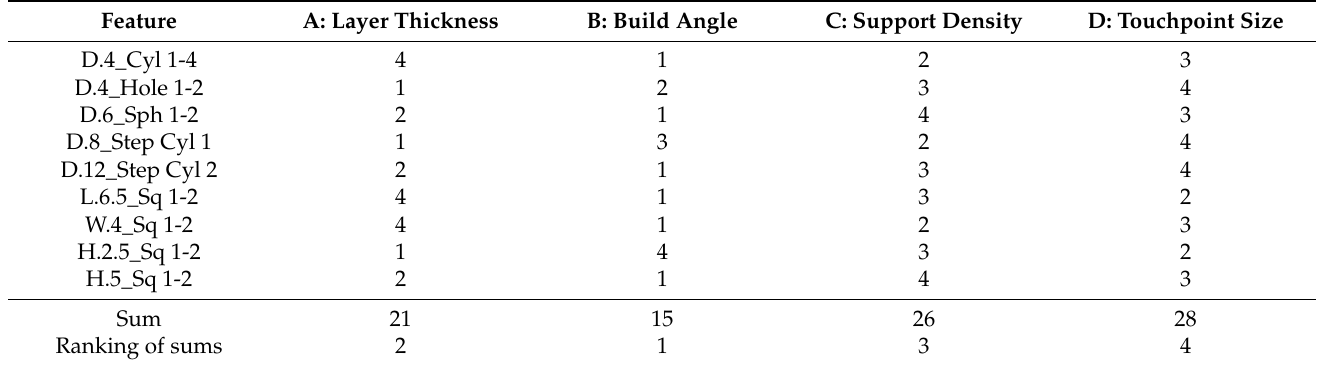
Table 17. S/N ratio ranking of parameters for dimensional accuracy of cast parts.